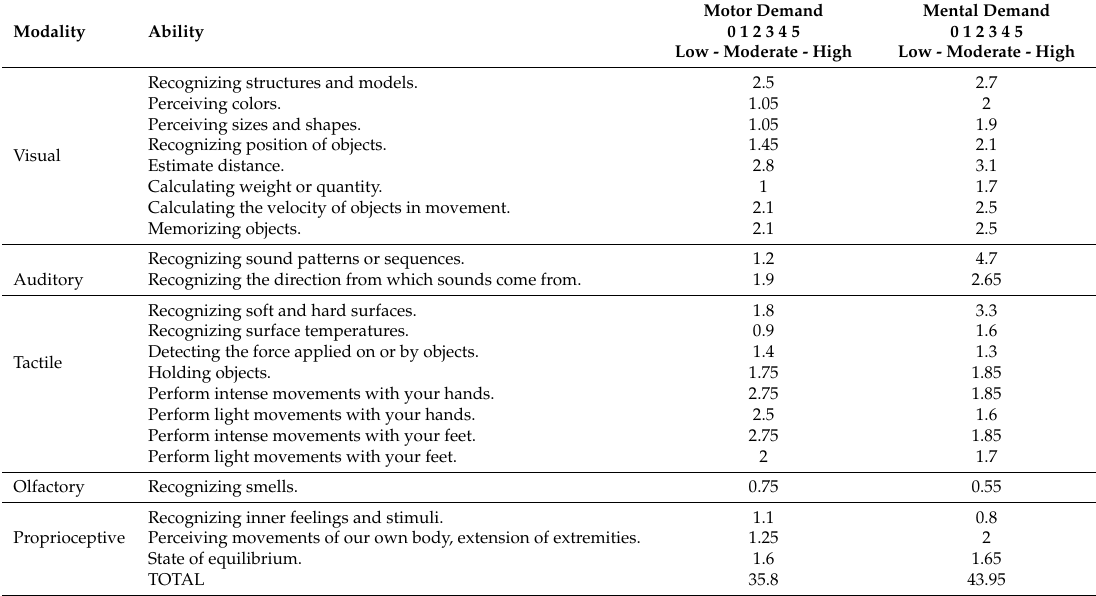
Table 10. Mean for the abilities and demands of Macoli version V1.